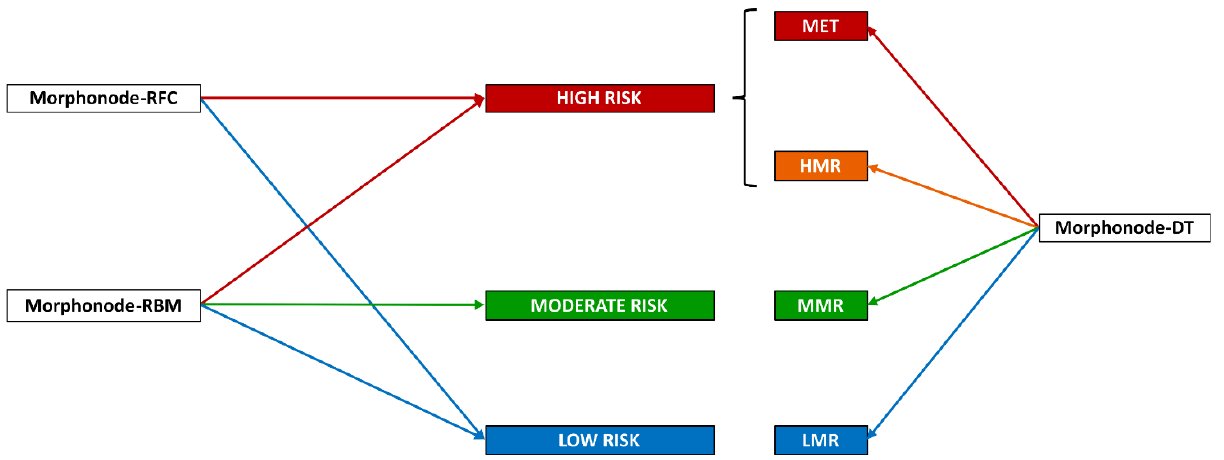
Figure 7. Morphonode Predictive Model workflow.